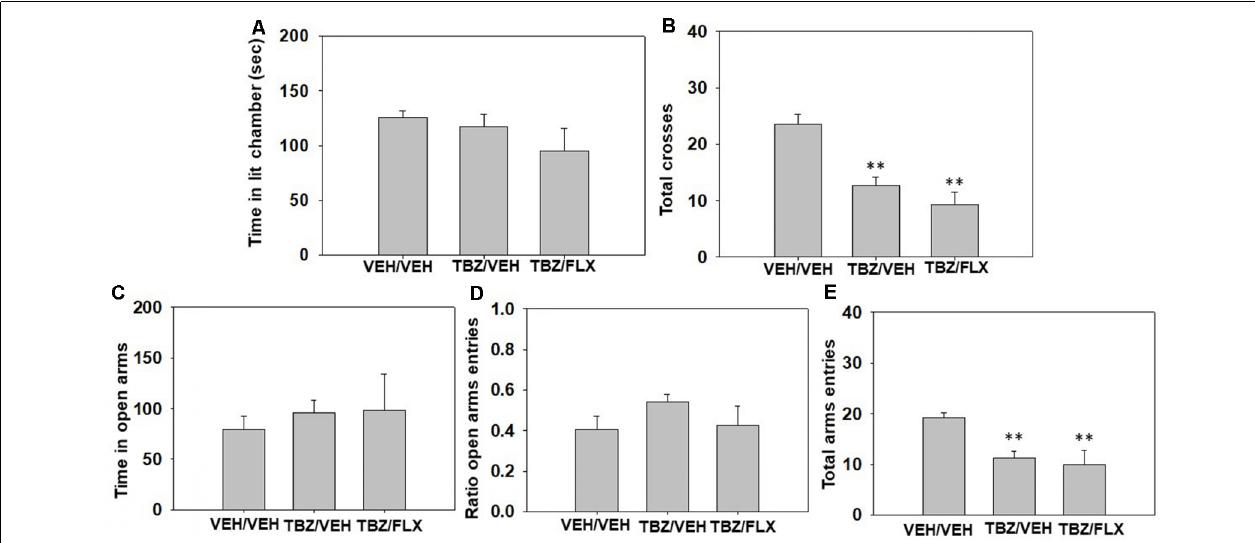
FIGURE 3 | Effect of TBZ plus fluoxetine combination (Veh + Veh, TBZ + Veh, or TBZ + Fluoxetine 20 mg/kg) on time spent in the lit chamber (A) and the total of entries between the two compartments (B) of the DL box, and on time spent in the open arms (C) , ratio to the open arms (D) , and the total of entries to the four arms (E) of the EPM during 5 min each test. Each dependent variable was analyzed by one-way ANOVA for independent samples. Bars represent mean ± SEM of accumulated seconds. ∗∗ p < 0.01 significantly different from vehicle-vehicle group.